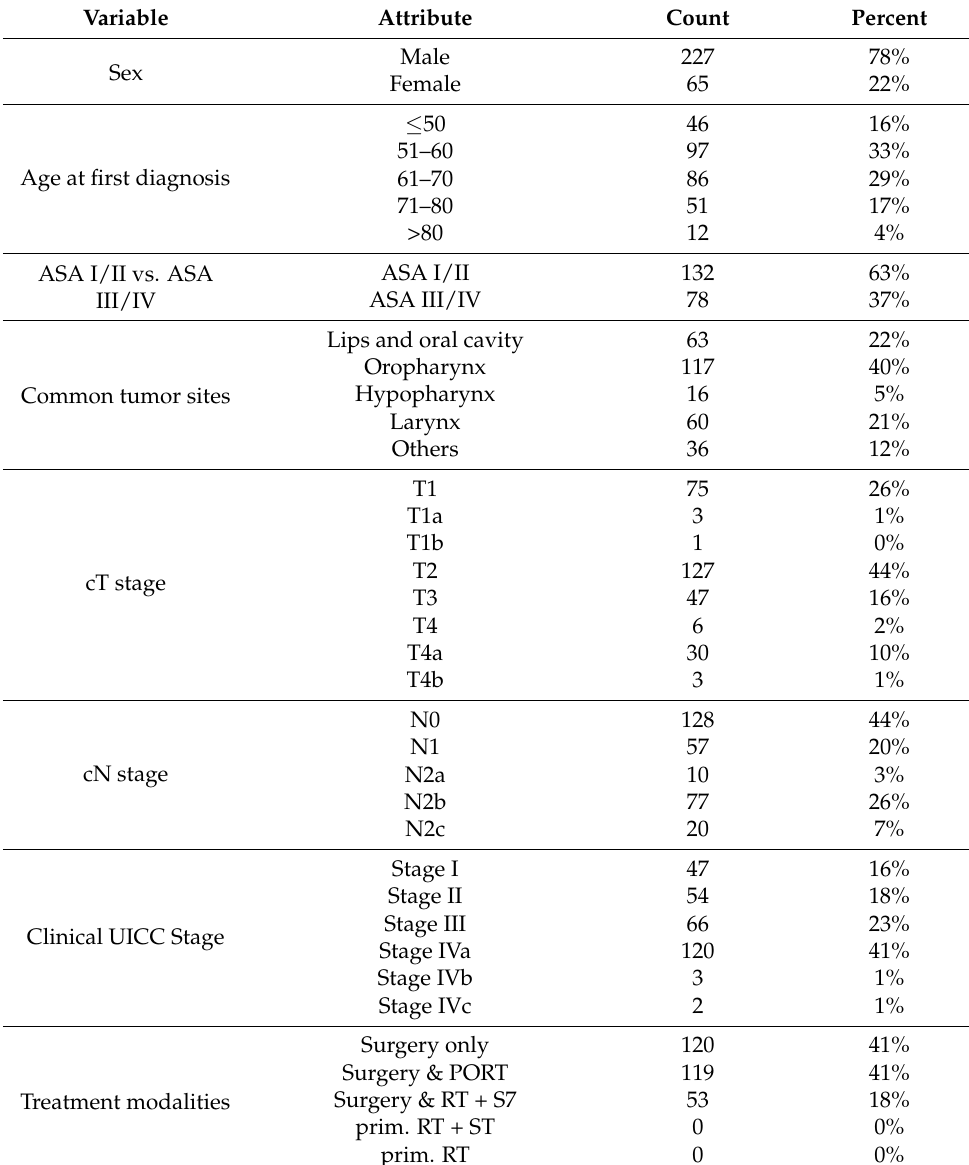
Table 1. Patient and disease characteristics of 292 patients with incident head and neck carcinoma, who received a ND as part of initial treatment. Clinical stage at time of diagnosis; prim. RT + ST: primary definitive radiotherapy with systemic therapy; prim. RT: primary definitive